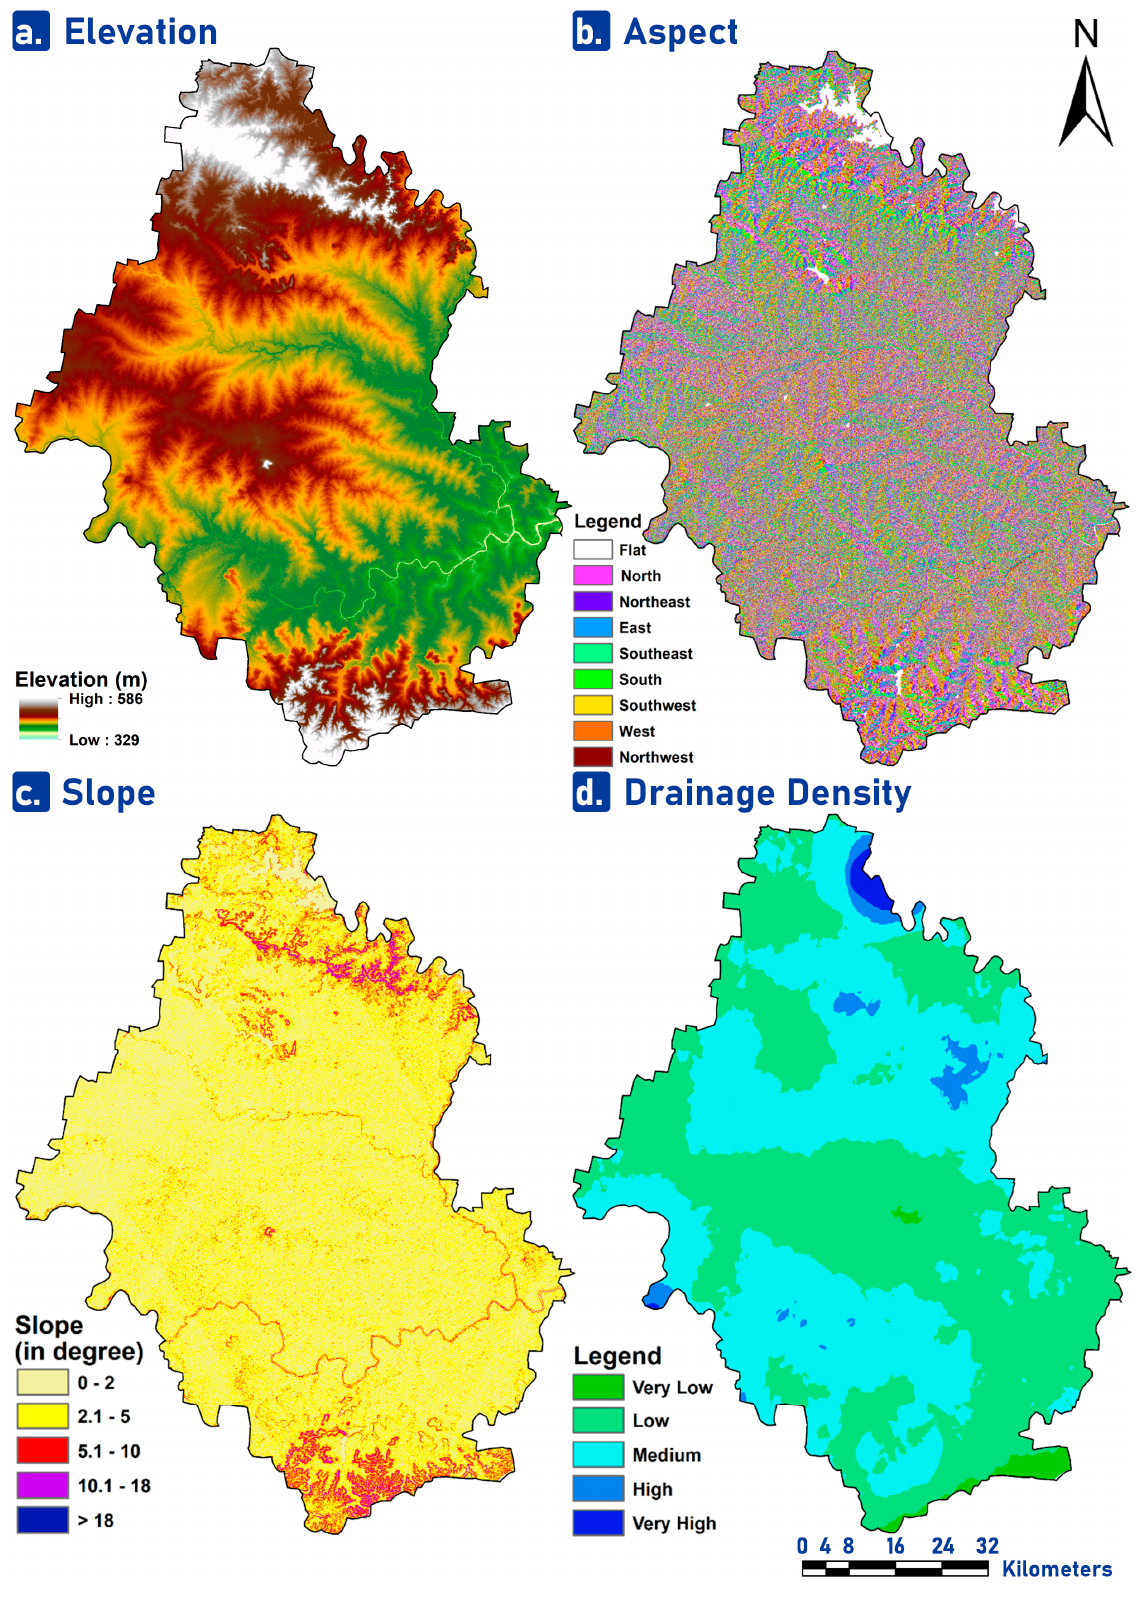
Figure 2. Factors affecting groundwater potential: ( a ) elevation, ( b ) aspect, ( c ) slope, ( d ) drainage density.